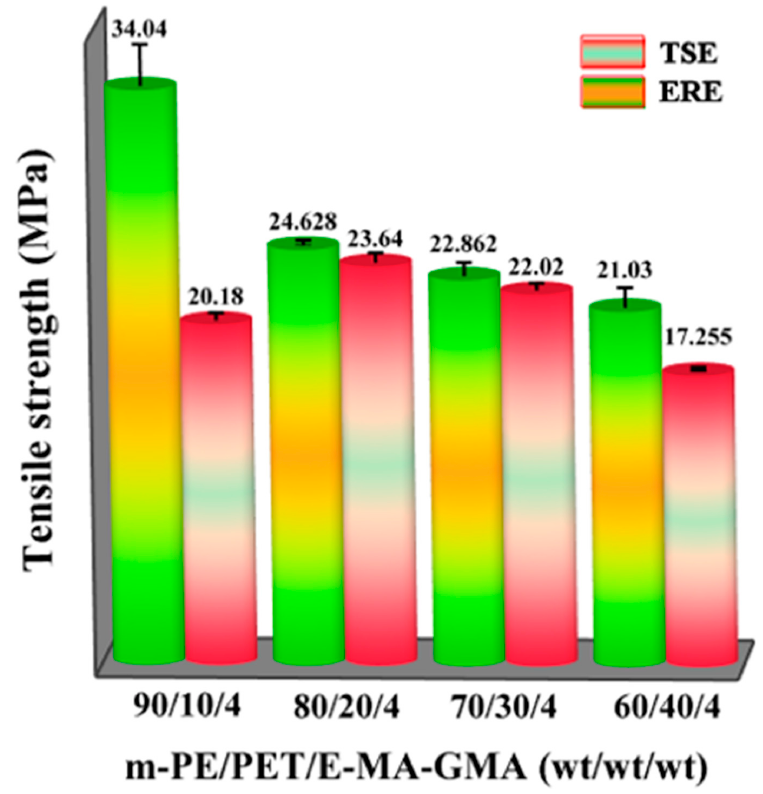
Figure 10. Tensile strength of m-PE/PET blends (4.0 wt% compatibilizer loaded) processed using ERE and TSE, respectively.